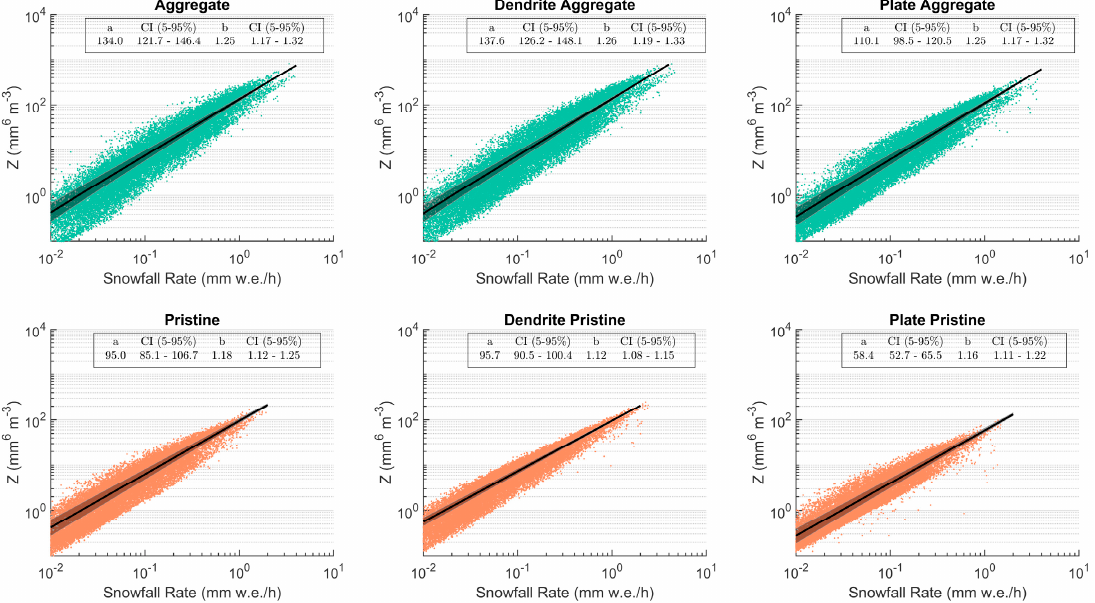
Figure 6. Scatter plots of the snowfall rate and radar reflectivity both computed from disdrometer observations for each snow category. Black lines and shaded areas represent the Ze–SR relationships obtained through Nonlinear Least-Squares fitting and their uncertainties, respectively. Text boxes contain the fitting parameters found for each snow